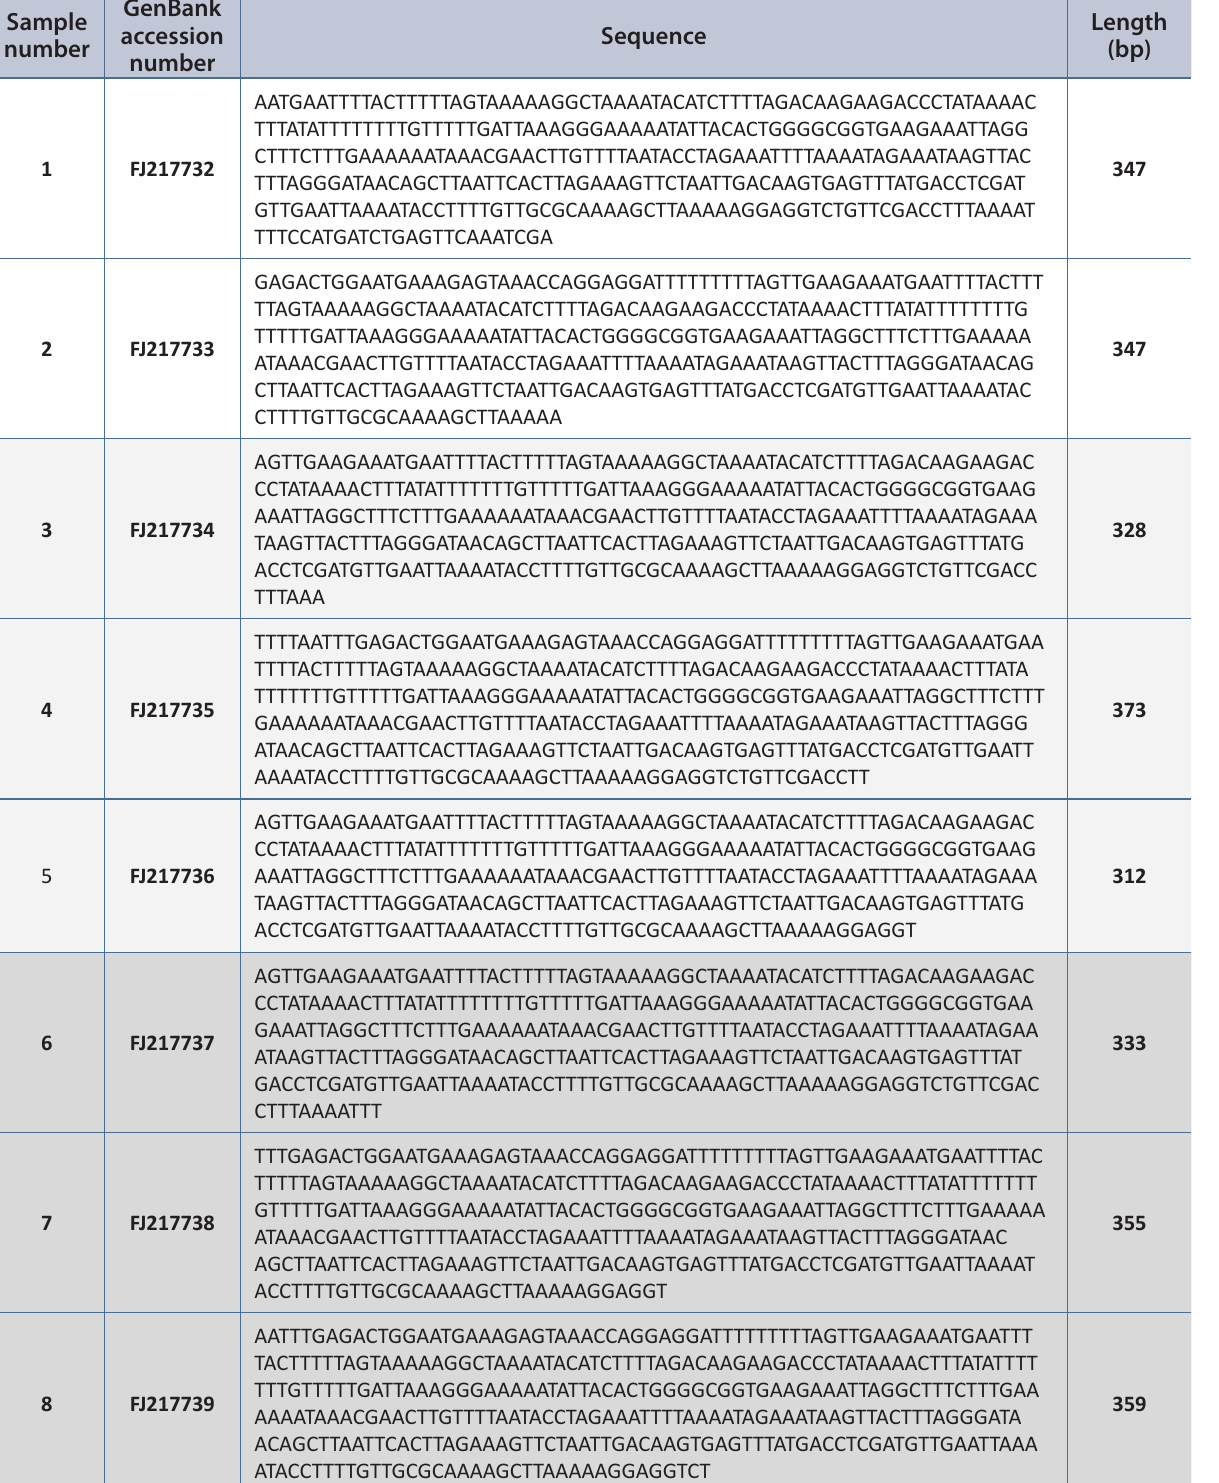
Table 1. Nucleotide sequences for eight samples of various sizes